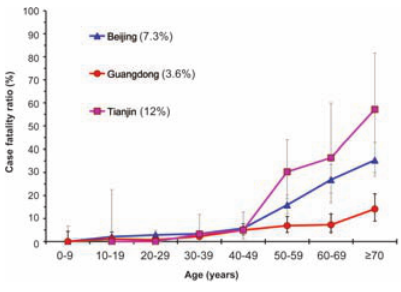
Figure 2. Comparison of the case fatality ratios for SARS patients in Beijing, Guangdong and Tianjin with age. Intervals indicate 90% binomially distributed confi- dence intervals. The values between paren- theses represent the overall case fatality ratio for each of the three areas.